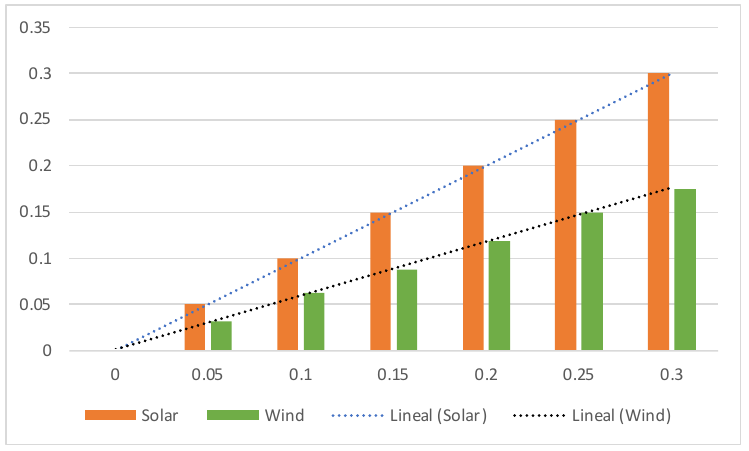
Figure 3. Trend of use for renewable